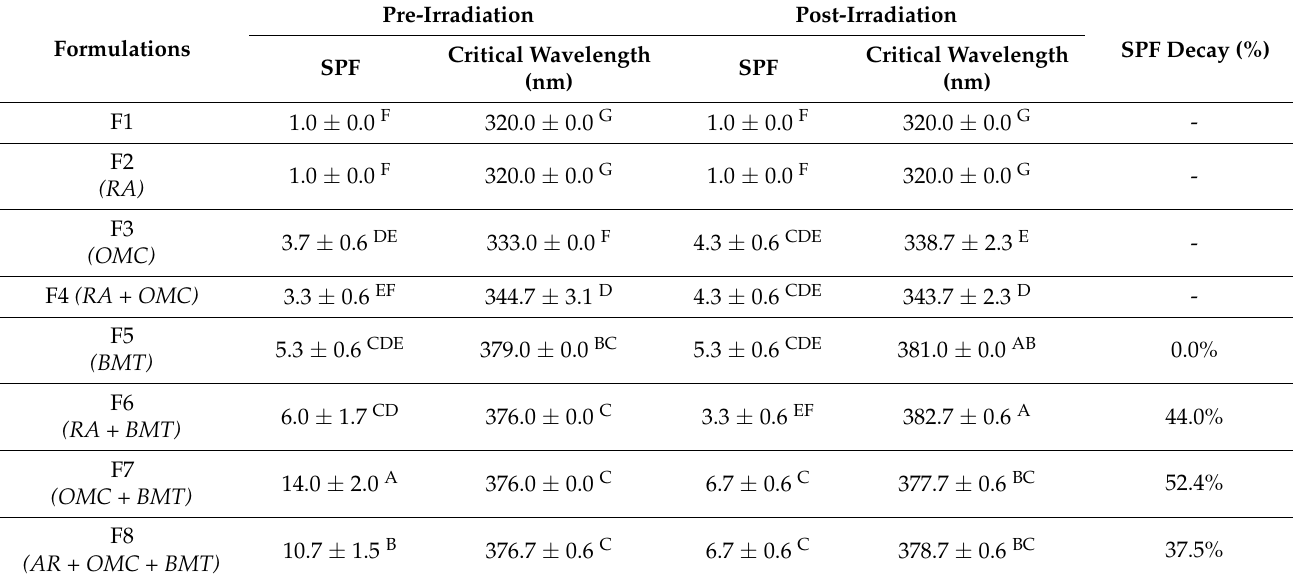
Legend: Different letters represent statistically significant differences between the groups. Each letter represents an analysis group statistically different from the other. Groups that share the same letter(s) are not statistically different from each other The results were evaluated according to the one-way ANOVA statistical test, followed by the Tukey test for comparison between groups (significance level = 0.05). (-) = Not